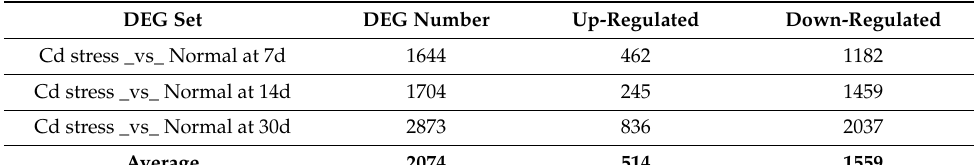
Figure 2. Correlation among RNA-Seq libraries at different time points of Cd stress. The X- and Y- axes represent each sample in a different time period. The expression values are log2-transformed median-centered FPKM. Cyan and purple color intensity indicates contig up-regulation and down- regulation, respectively.